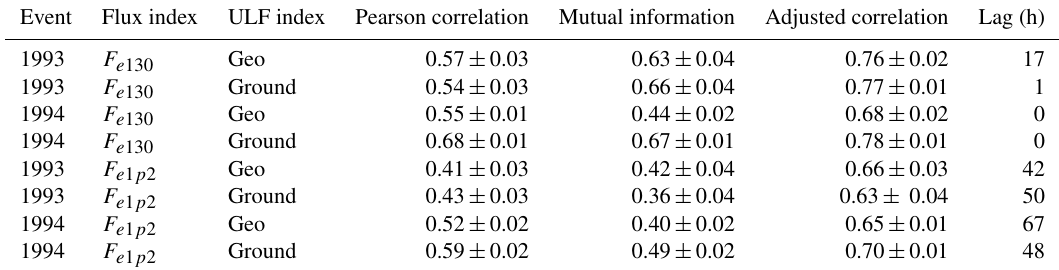
Table 1. Maximum values in correlation and mutual information for positive lags and associated adjusted correlation. Event Flux index ULF index Pearson correlation Mutual information Adjusted correlation